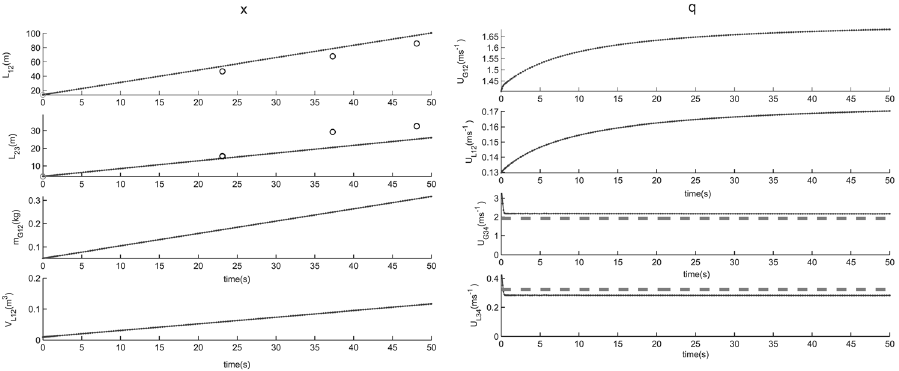
Figure5. ModelverificationagainstSINTEFMediumScaleThree-PhaseFlowLoop: x and q (solid) compared with x est and q est (dashed). available, and the slug length and position were deduced from holdup-measurements